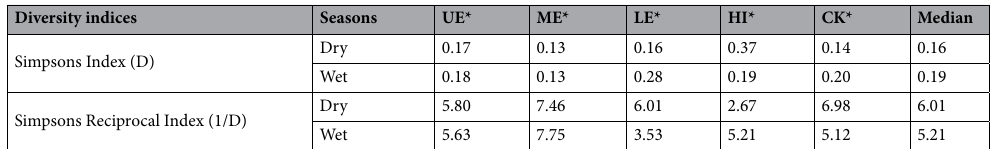
Table 4. Phytoplankton diversity index values during the dry and wet seasons. *UE = Upper estuary, ME = Middle estuary, LE = lower estuary, CK = Char Kukrimukri, HI = Hatiya